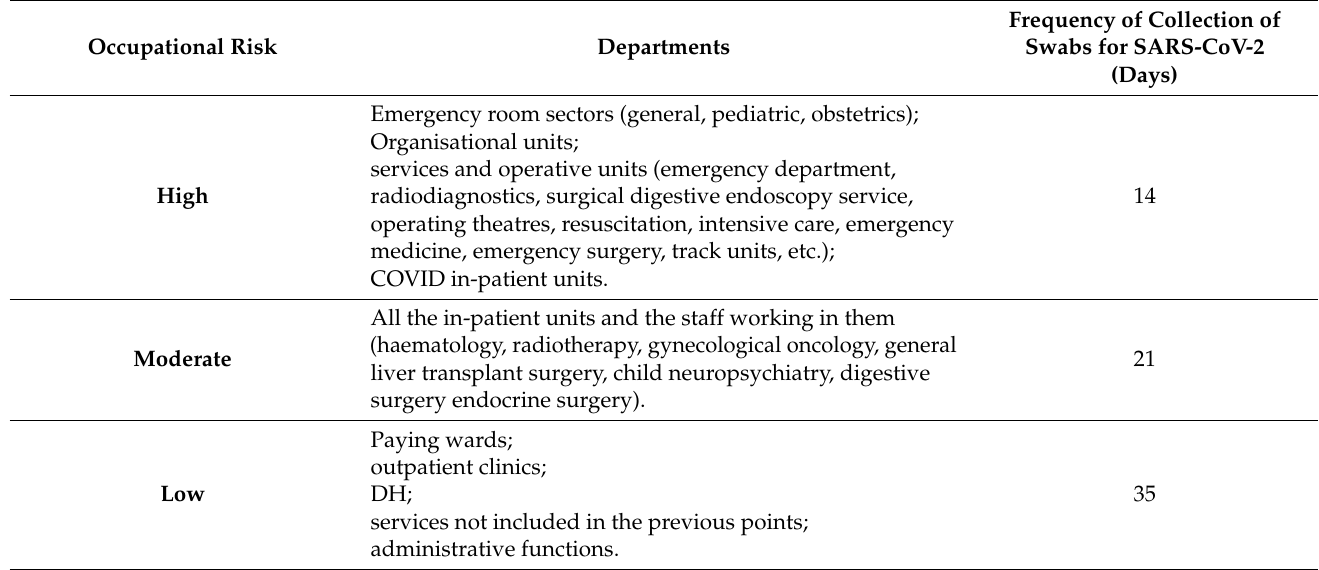
Table 1. Occupational risk profile, corresponding departments and frequency of collection of swabs for